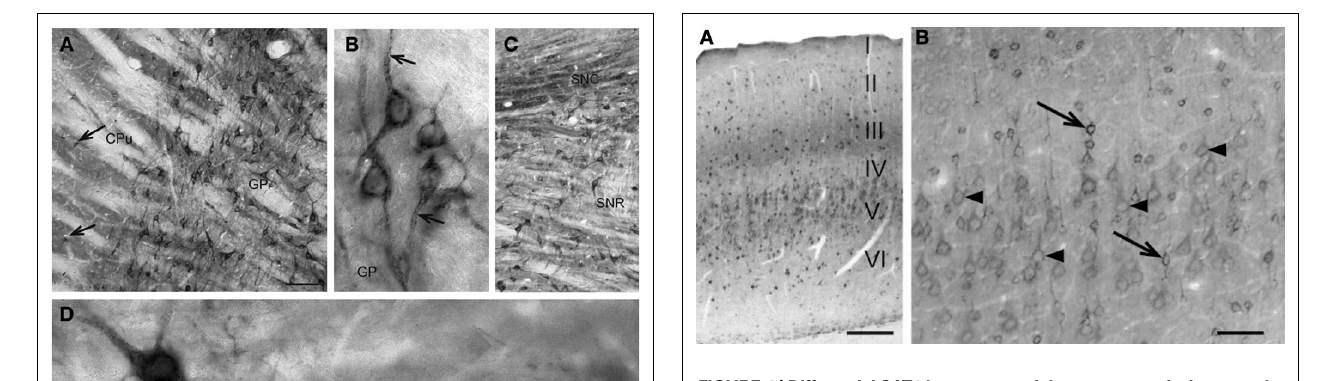
FIGURE 4 | Differential SAT1 immunoreactivity among cortical neuronal subpopulations. (A) SAT1 immunoreactive cells are detected in all layers of the neocortex. Layers III and V stand out as broad bands diffusely stained in the neuropil. (B) In the layer V, strong immunostaining for SAT1 is detected in scattered small neuron-like cells (arrows) while larger pyramidal-like cells (arrow heads) are moderately or weakly immunolabeled. I–VI: layers 1–VI. Scale bars: 100 µm (B) , 200 µm (A)